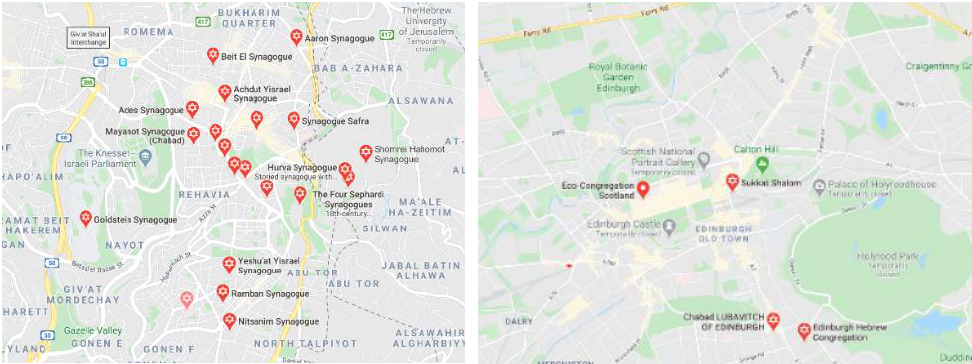
Figure 1. Frequency of “ Synagogue ” on the geographical contexts of West Jerusalem ( left ) and Edinburgh ( right